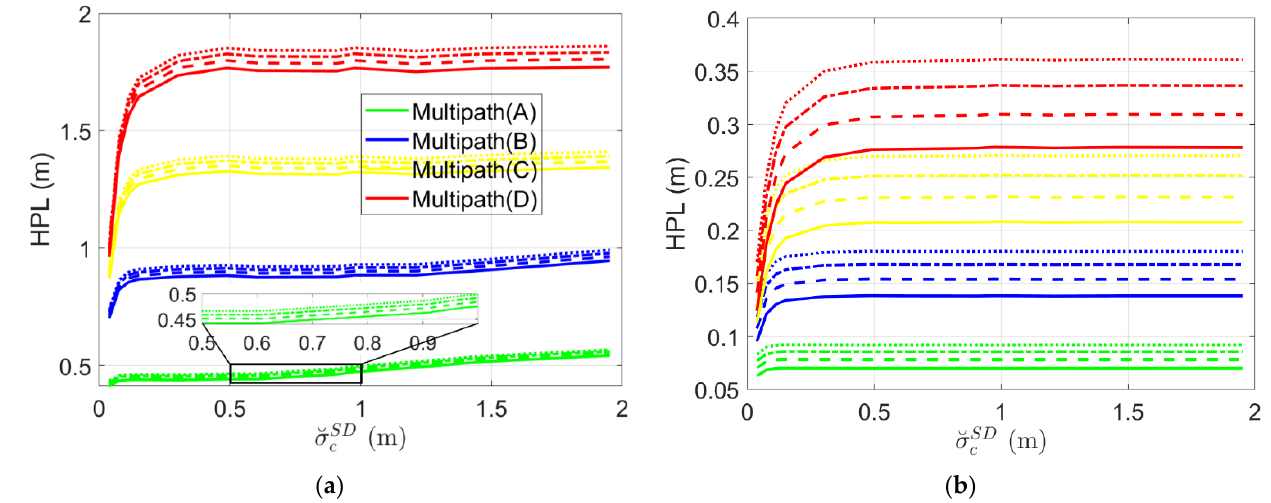
Figure 12. Change of the HPLs with the overbounding standard deviations of the between-satellite network corrections in: ( a ) the ambiguity-float case; ( b ) the ambiguity-fixed case, at the end of a half-hour session. The solid, dashed, dashed-dotted and dotted lines represent the PMI H of 2 × 10 − 3 , 2 × 10 − 4 , 2 × 10 − 5 and 2 × 10 − 6 , respectively.